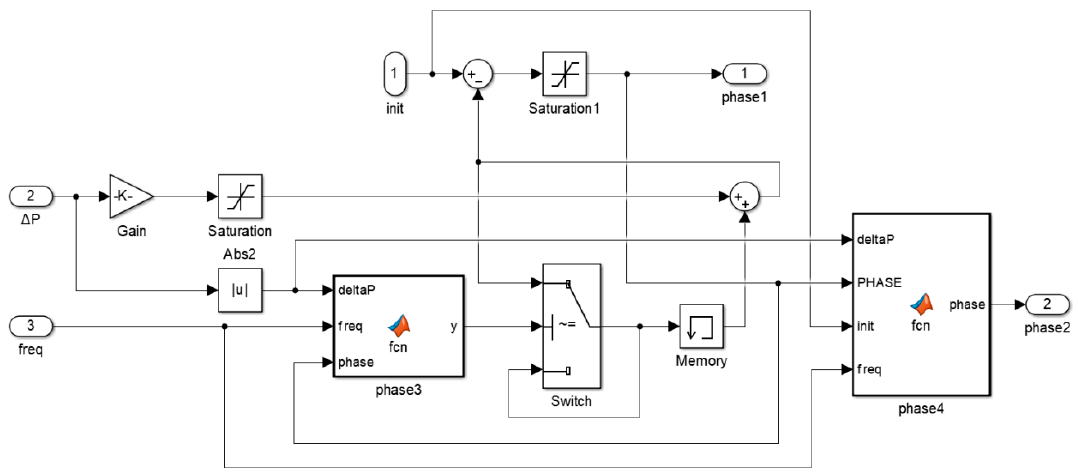
Figure 12. Internal structure of a PSPWM controller.